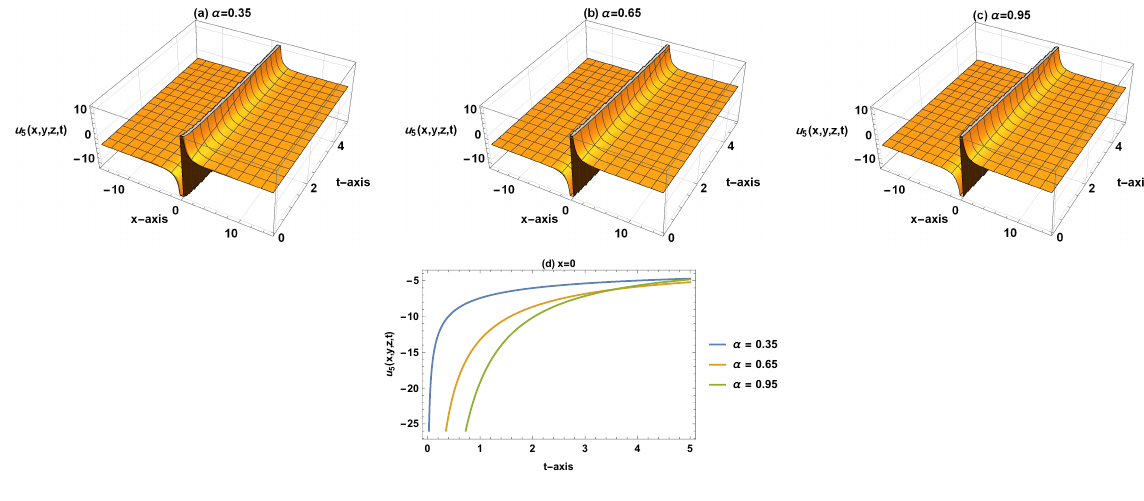
Fig. 4: (a)-(d) The wave solution u 4 ( x , y , z , t ) given by (28) in 3D-and 2D-plots when y = z = 0 .